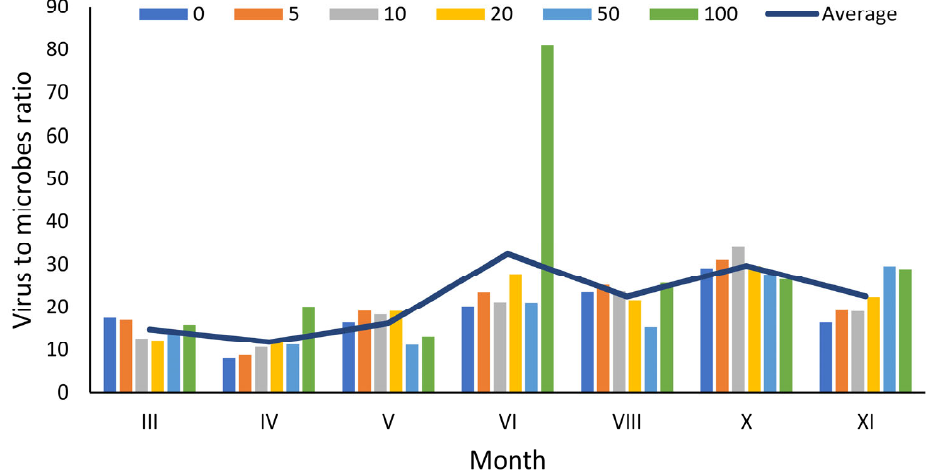
Figure 3. Monthly values with mean of virus-to-microbe ratio (VMR) for the sampled station.